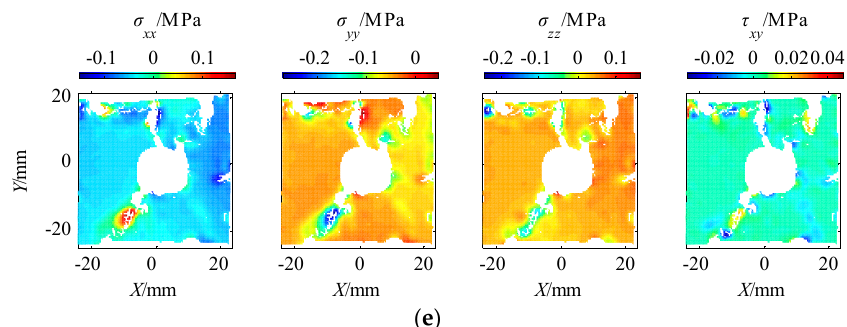
Figure 6. Revolution of stress field: ( a ) elastic starting point; ( b ) crack initiation; ( c ) crack failure; ( d ) sample failure; and ( e ) finally destroyed.